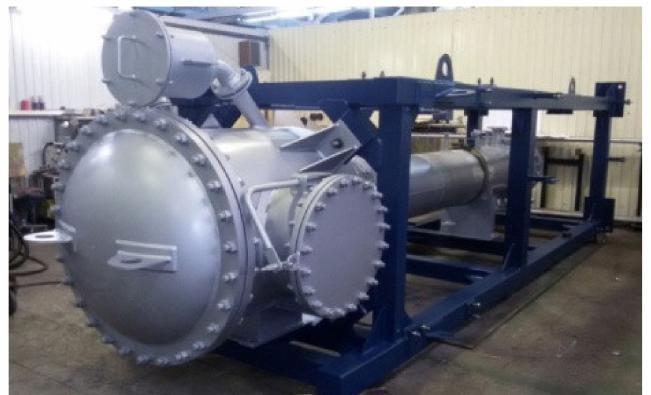
Figure 26. Reactor Block.